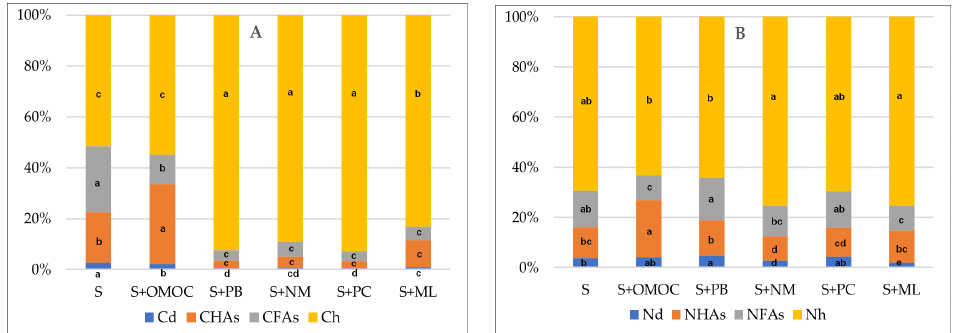
Figure 2. Share of carbon ( A ) and nitrogen ( B ) in organic matter fractions: Cd: carbon content after decalcification; CHAs: carbon content of humic acids; CFAs: carbon content of fulvic acids; Nd: nitrogen content after decalcification; NHAs: nitrogen content of humic acids; NFAs: nitrogen content of fulvic acids. Values represented by bars marked by the same small letter are not significantly different at p = 0.05.